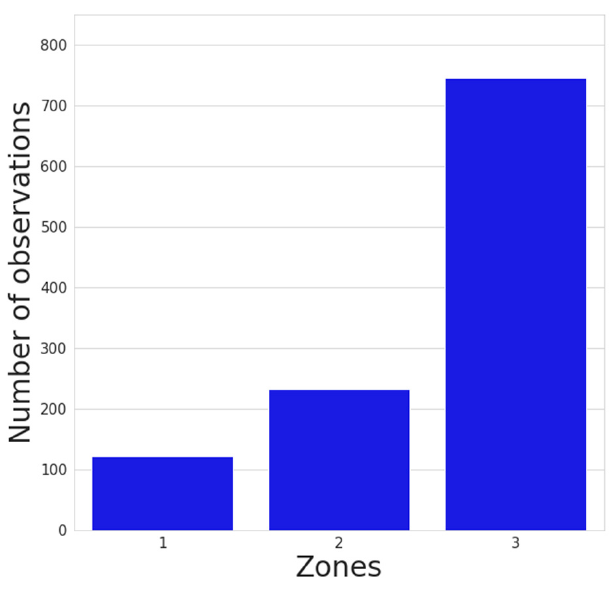
Figure 6. Distribution of interventions across zones.